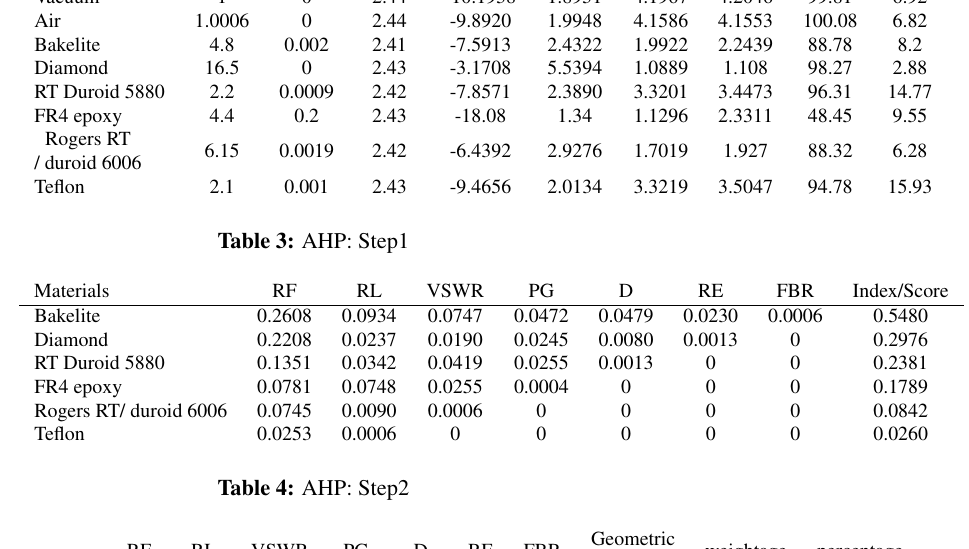
Table 4: AHP: Step2